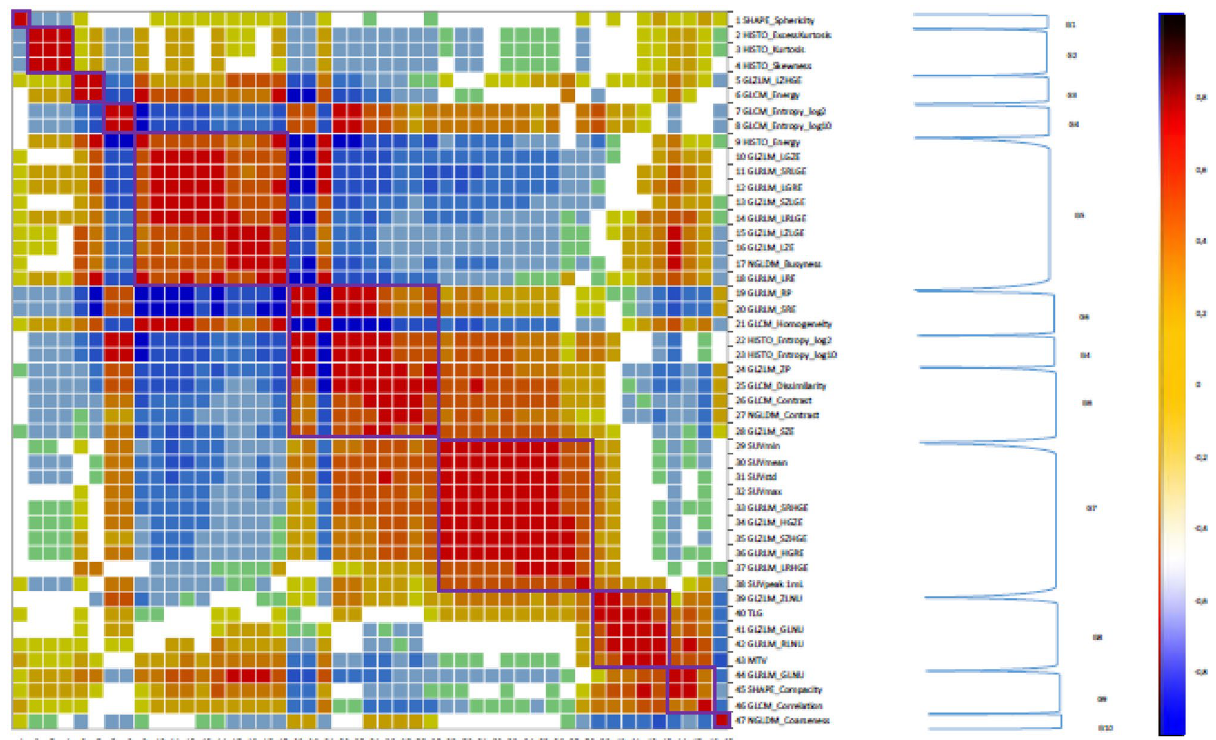
Figure 1. Pearson correlation heatmap for all textural features and Positron-Emission Tomography (PET) standard